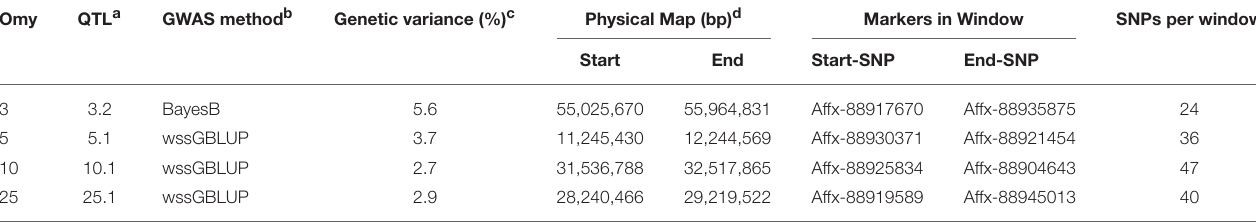
a From each QTL, the window with the highest explained genetic variance is presented in this Table. The QTL nomenclature was based on chromosome number and physical genome map positions of the SNPs that flanked each QTL region within the chromosome, where the region with the lowest position numbers determined to be QTL1, the next QTL2 and so on (i.e., Omy3: QTL 3.1, 3.2, etc.). b GWAS was conducted using Bayesian variable selection model BayesB (BayesB) and weighted single-step GBLUP (wssGBLUP) methods. BayesB used 1Mb exclusive-consecutive windows and wssGBLUP used 1Mb moving-sliding windows. c Explained genetic variance by tested window (%).